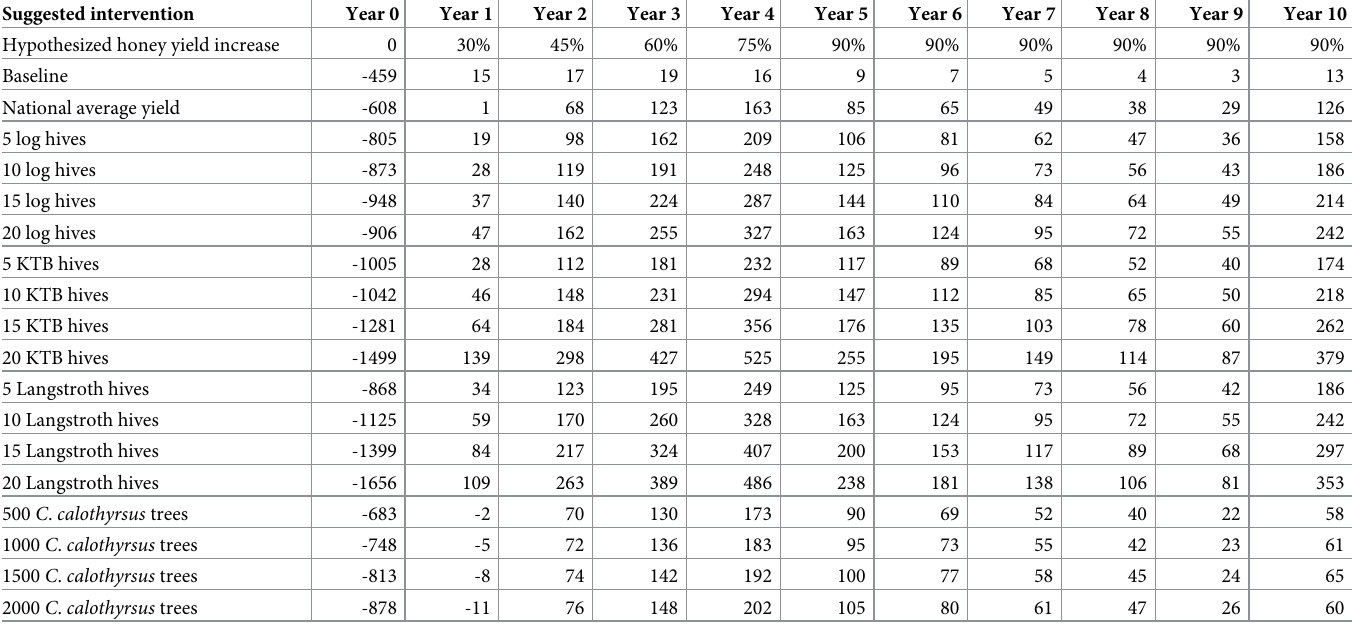
Table 5. Income generating interventions for beekeepers � .